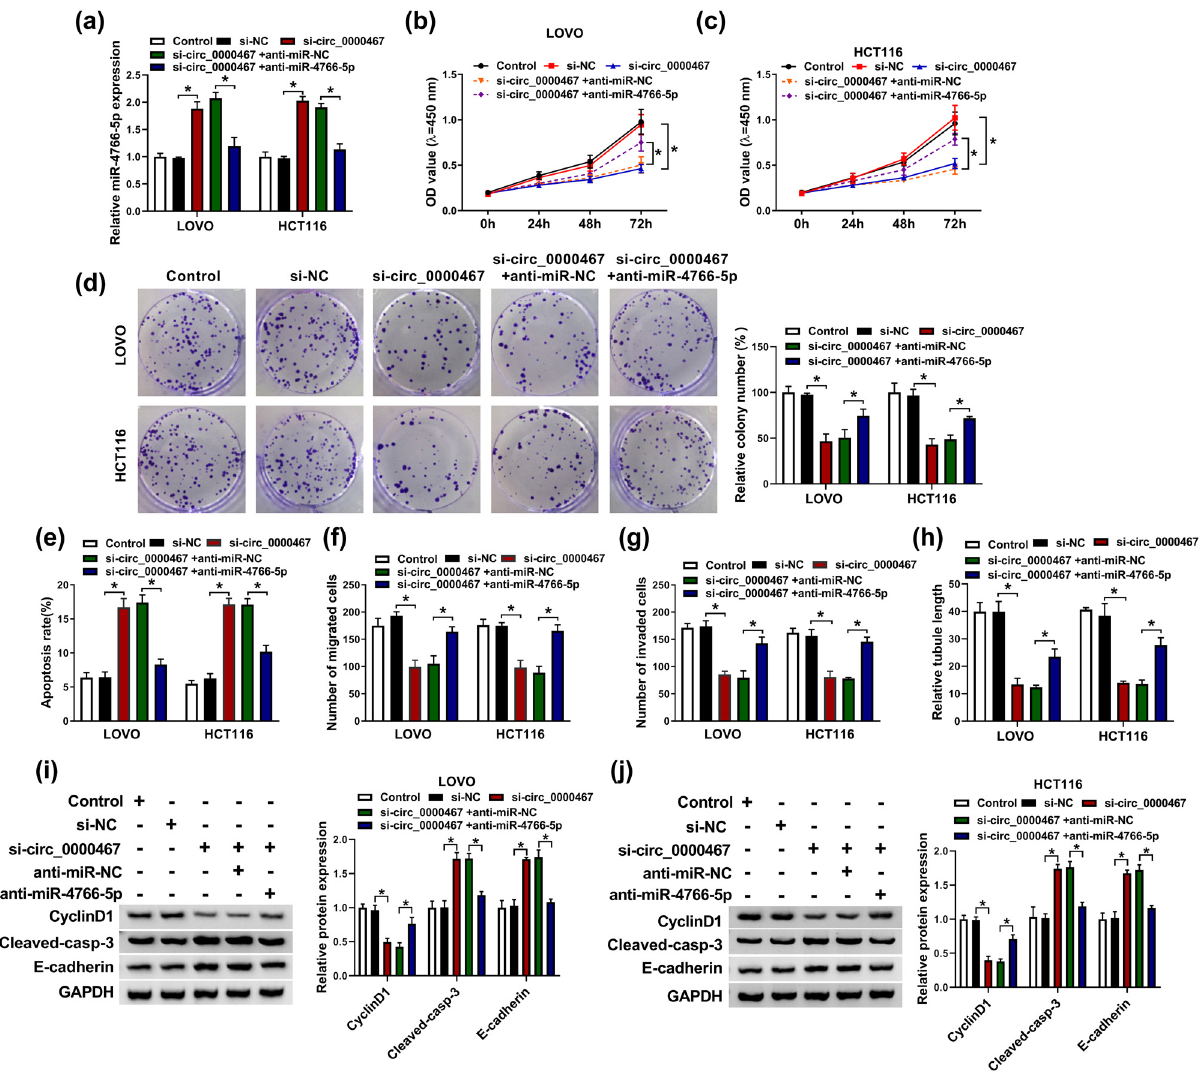
Figure 4: Downregulation of miR - 4766 - 5p restored the si - circ_0000467 - induced e ff ect on CRC cells. ( a ) The RT - qPCR was used for miR - 4766 - 5p detection after transfection of si - circ_0000467 and si - circ_0000467 + anti - miR - 4766 - 5p or the matched controls. ( b – d ) The proliferative abilities of the above - transfected LOVO and HCT116 cells were detected with the CCK - 8 assay ( b and c ) and colony formation assay ( d ) . ( e ) Apoptotic rate was estimated through fl ow cytometry. ( f and g ) Transwell assay was performed to determine cell migratory ( f ) and invasive ( g ) abilities. ( h ) Tube formation assay was performed to measure the angiogenesis. ( i and j ) WB was used to quantify the protein expression of cyclinD1, cleaved - casp - 3, and E - cadherin. * P <